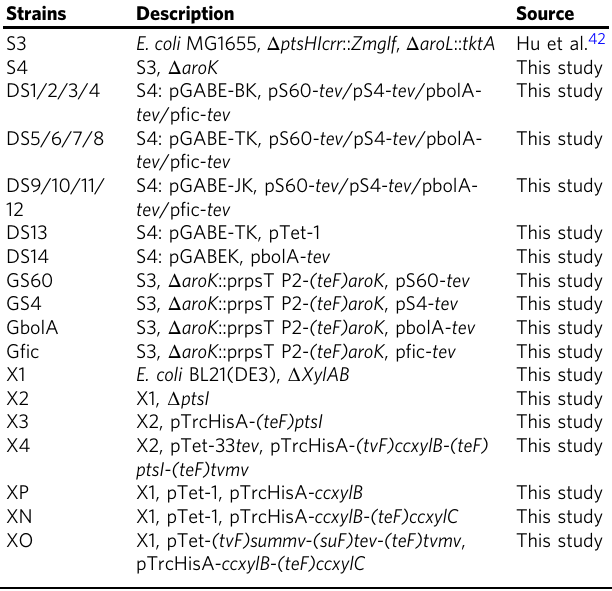
Table 1 Bacterial strains used for tool